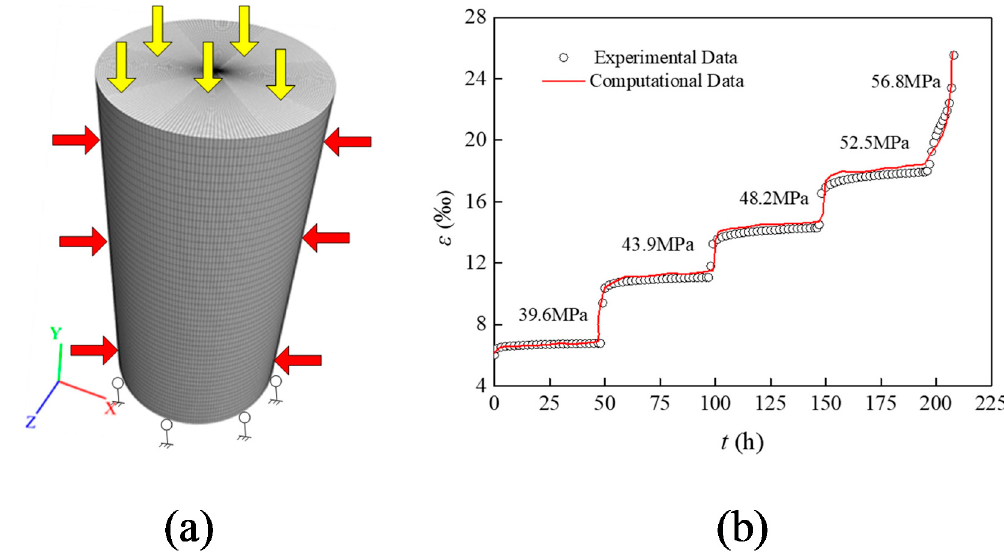
Figure 12. ( a ) Three-dimensional creep numerical model of AS. ( b ) Comparisons between numerical results and experimental results.